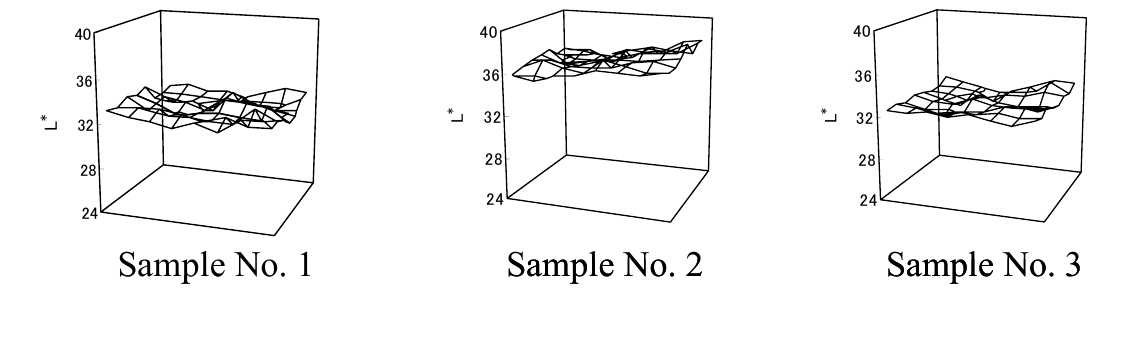
Figure 7. L * values in dyed cloth after washing